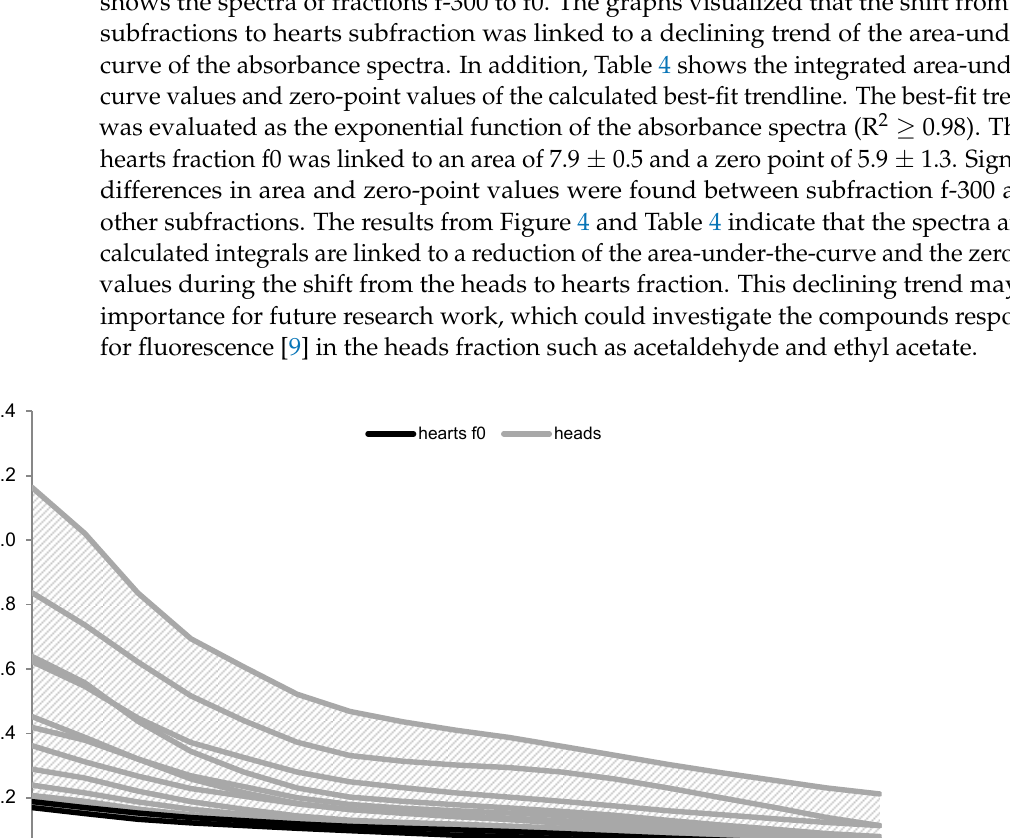
Figure 3. Ultraviolet absorbance spectra of heads, hearts and tails fractions gained from distillates of mashes No. 1–10. Each graph indicates the average spectrum with standard deviation ( n = 10).